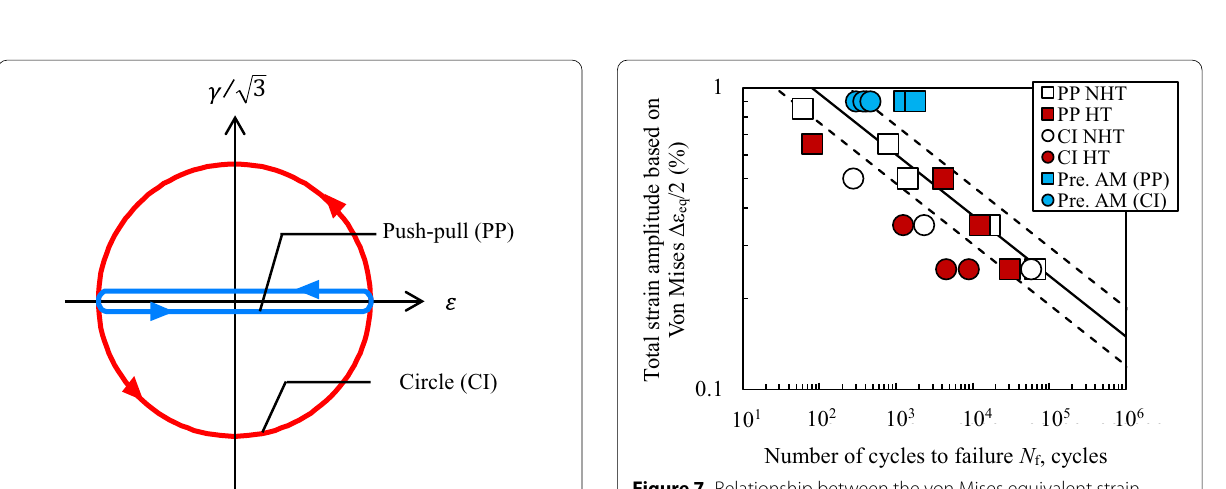
Figure 7 Relationship between the von Mises equivalent strain amplitude Δε eq /2 and failure life N